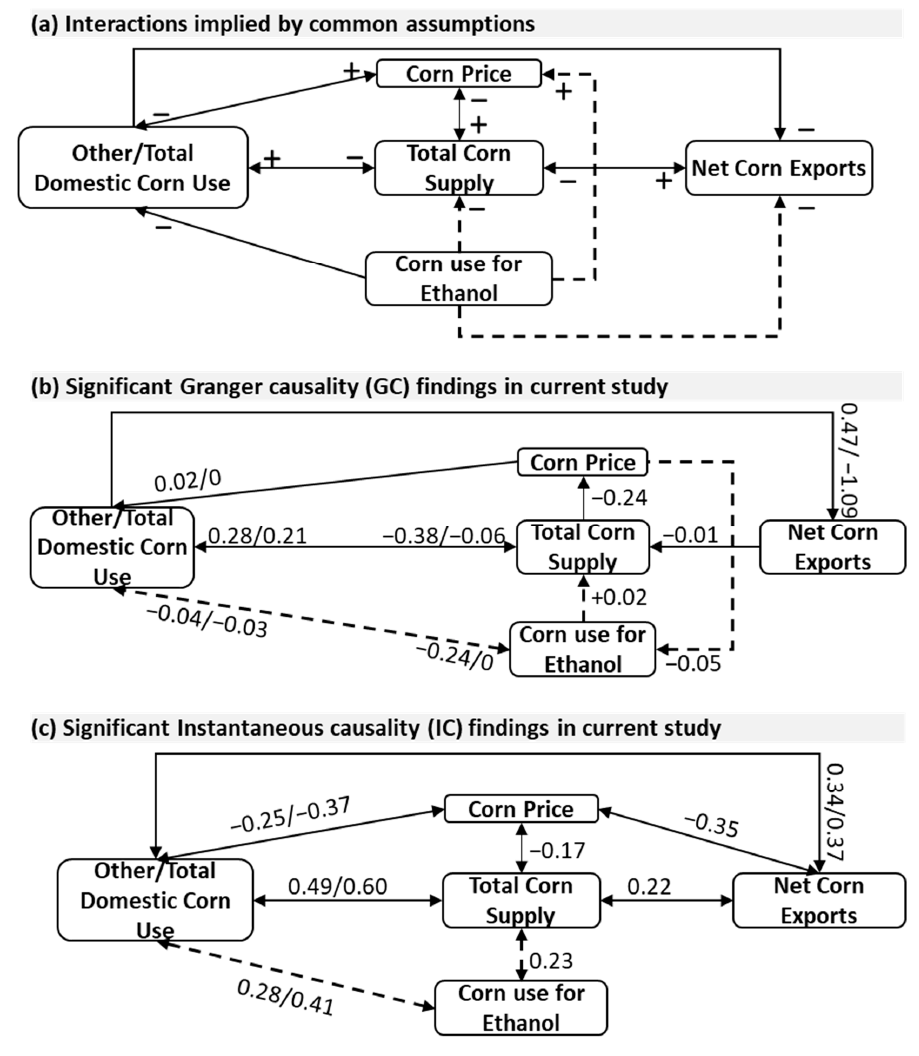
Figure 3. Interactions among corn market variables based on common assumptions (panel a ) versus Granger (panel b ) and Instantaneous (panel c ) causality results in the current study. Relationships among corn use for ethanol and other variables are emphasized by dashed lines Note that Other and Total domestic corn use are combined in this figure for clarity.